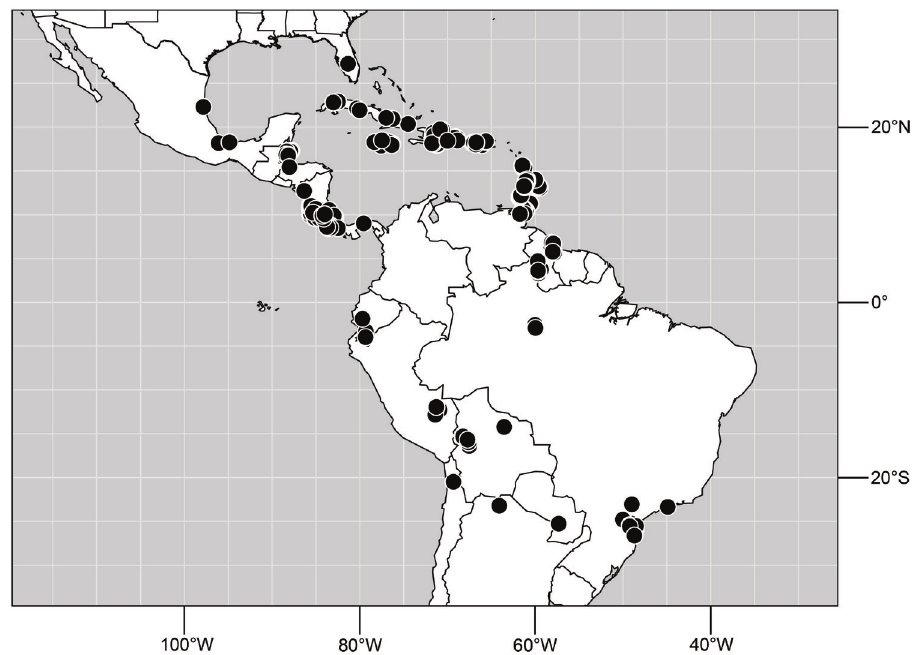
Figure 95. Distribution of Hydrochasma incisum (Coquillett)